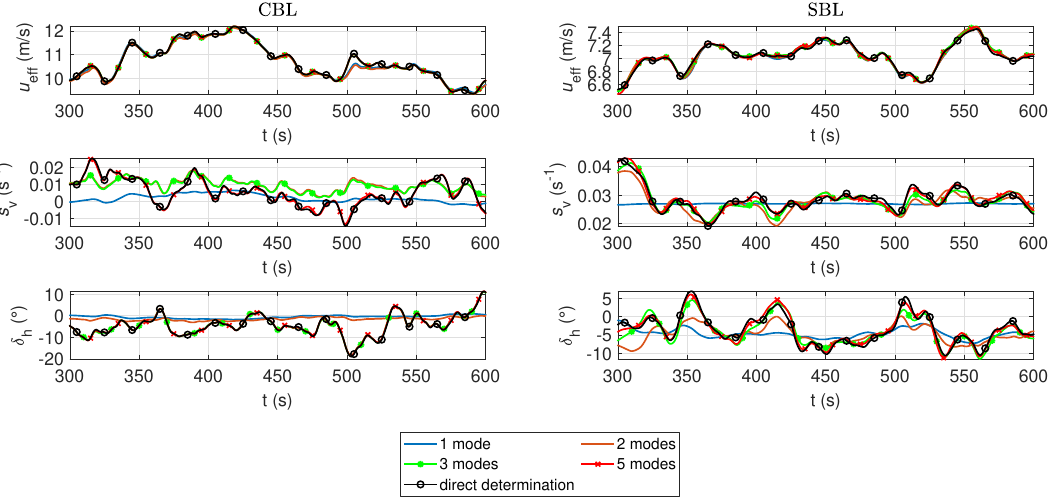
Figure 8. The time series of the wind field parameters u eff , s v and δ h extracted at a sampling rate of 1 Hz for a duration of 300 s for different POD reconstructions for the CBL and SBL